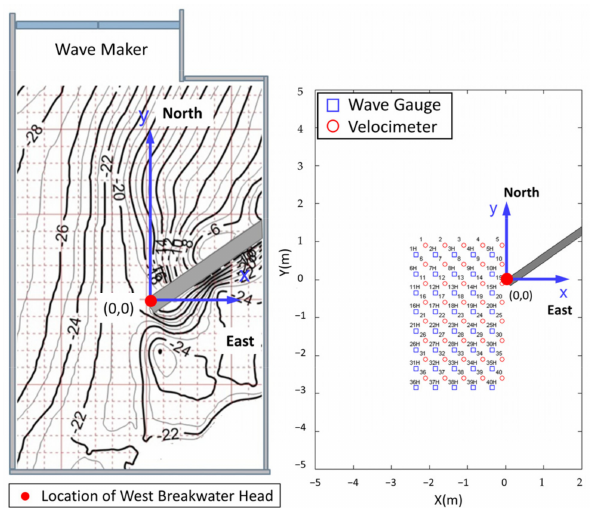
Figure 4. The topography and measurement device setup in wave